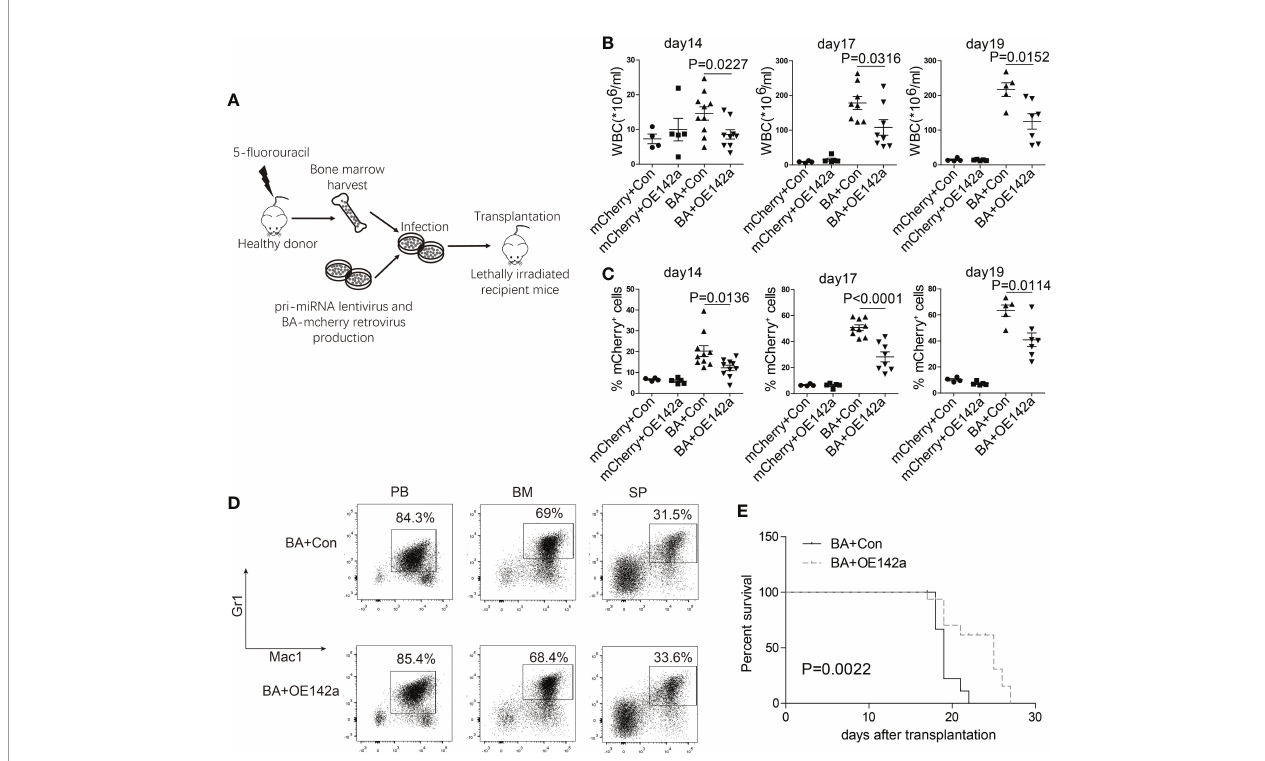
FIGURE 7 | miR-142a may act as a suppressor in CML progression. (A) Schematic of miR-142a treatment on BA-induced CML mice. (B) Follow-up analysis of the PB white blood cell (WBC) count after transplantation. (C) Follow-up analysis of the proportion of mCherry + cells in PB. (D) Immunophenotype analysis of mice in BA and BA+miR-142a group. (E) Kaplan-Meier survival curve of mice inoculated with miR-142a overexpression or control lentivirus. Results are mean ± SEM, p value was assessed by unpaired t